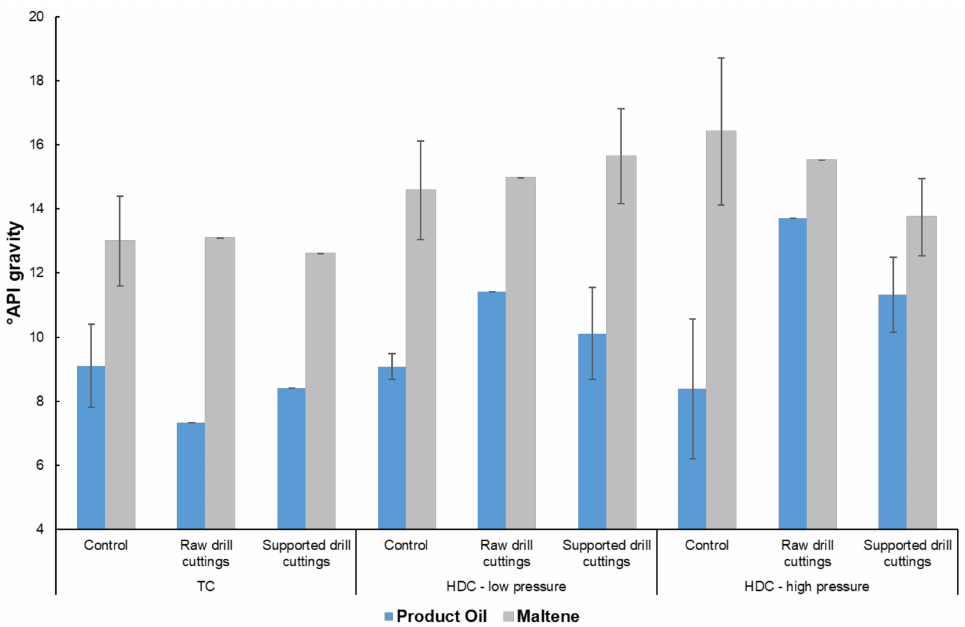
Figure 9. Results of ◦ API gravity measurements at 24 ◦ C for both the product oil and maltene fraction. The pressure was 70 psi and 365 psi for low and high-pressure runs,